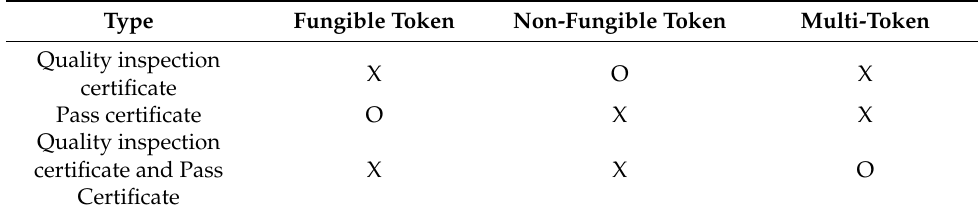
Table 3. Possible token standards.